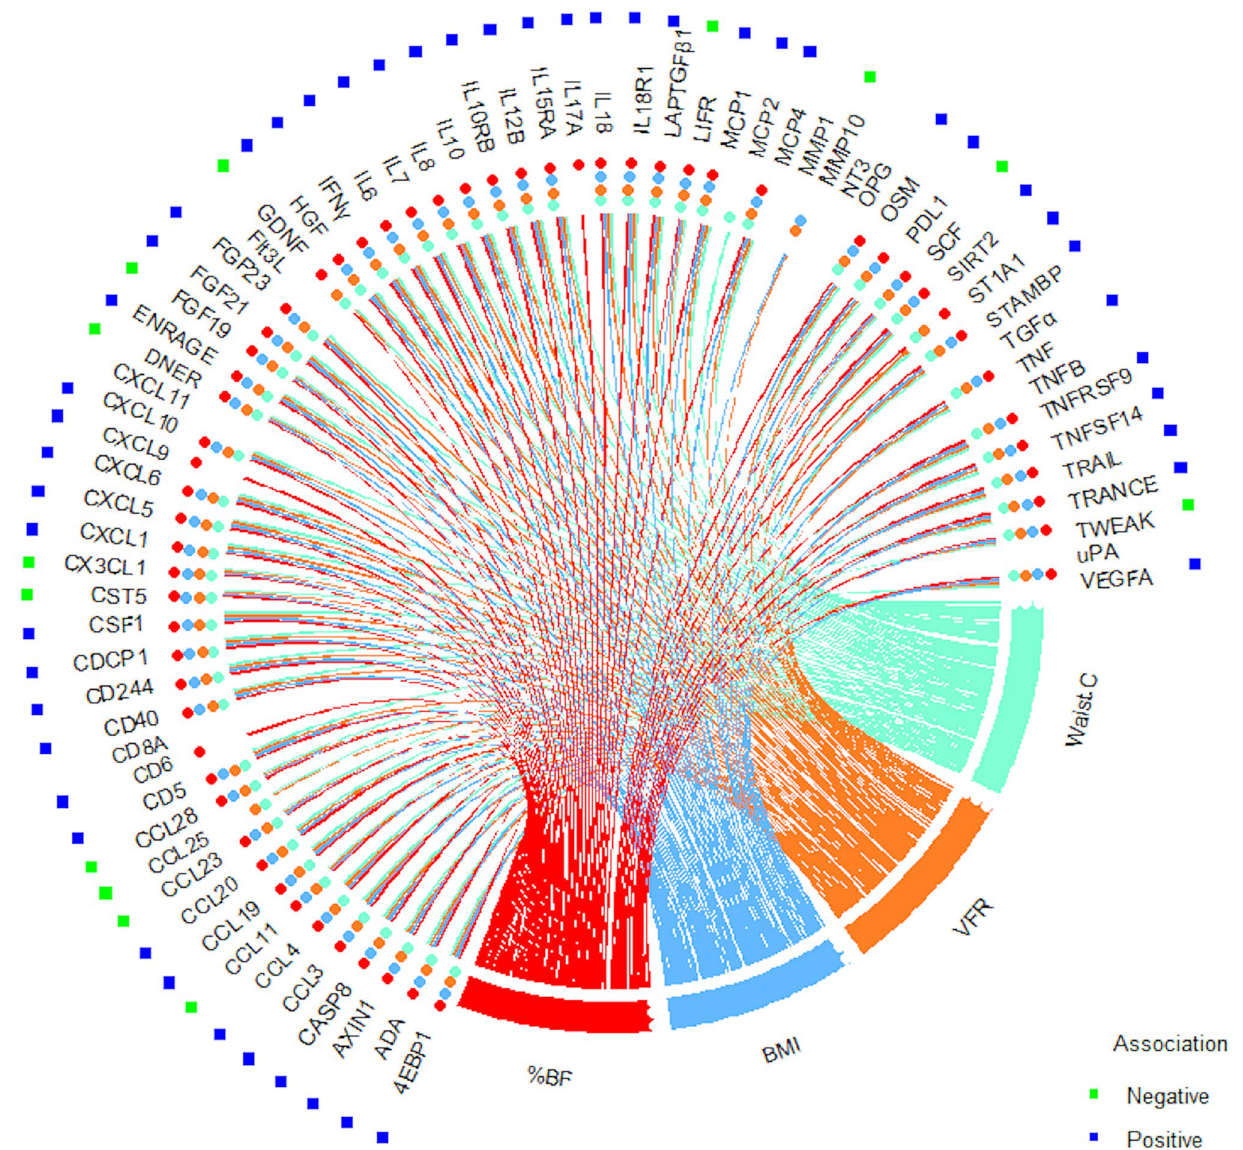
Figure 2. Associations between body composition measurements and protein levels. Statistically significant (i.e. nominal p-value < 0.05 at < 0.05 FDR) negative (green dot) and positive (blue dot) association with %BF (red line and dot), BMI (light blue line and dot), VFR (orange line and dot), and waist circumference (light green line and dot) are shown in circos plot based on results from linear regression models of %BF, BMI, VFR and waist circumference respectively. Adjusted for sex, smoking, e-cigarette use, snuff use, and age at